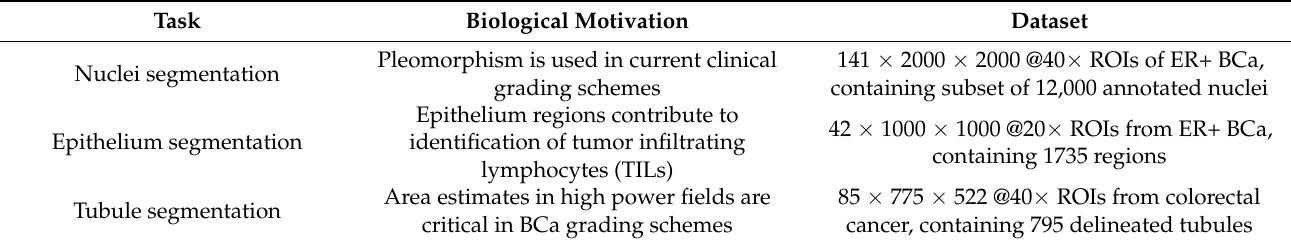
Table 1. Digital pathology task descriptions.